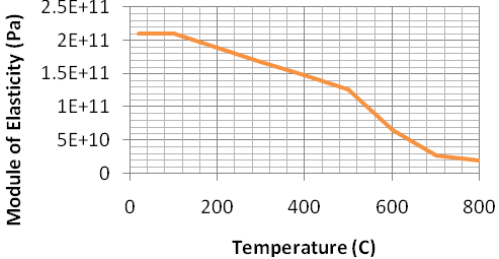
Fig. 3. Module of elasticity versus temperature.